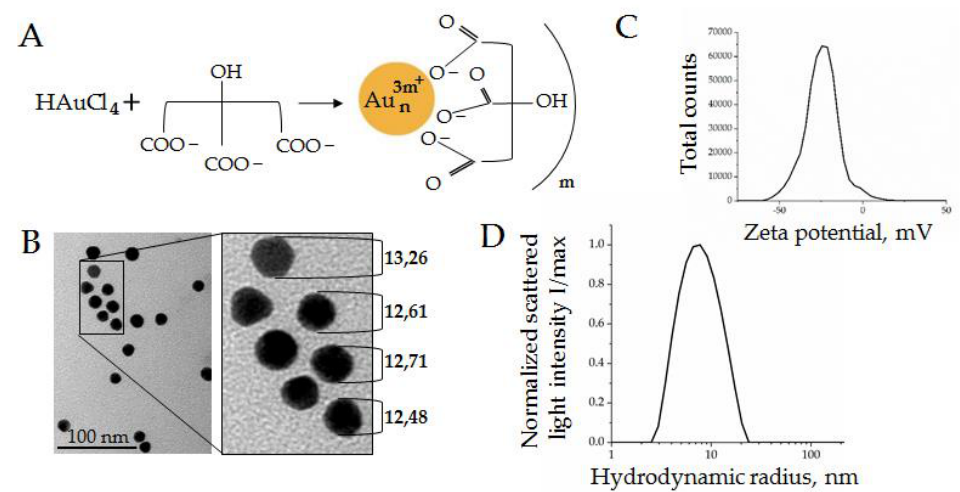
Figure 2. AuNPs characteristics: ( A ) Schema of AuNPs stabilization by citrate solution; ( B ) SEM micrographs of AuNPs; ( C ) ζ -potential measured by a Zetasizer Nano ZS; ( D ) hydrodynamic radius distribution of the normalized scattered light intensity of AuNPs obtained by DLS.